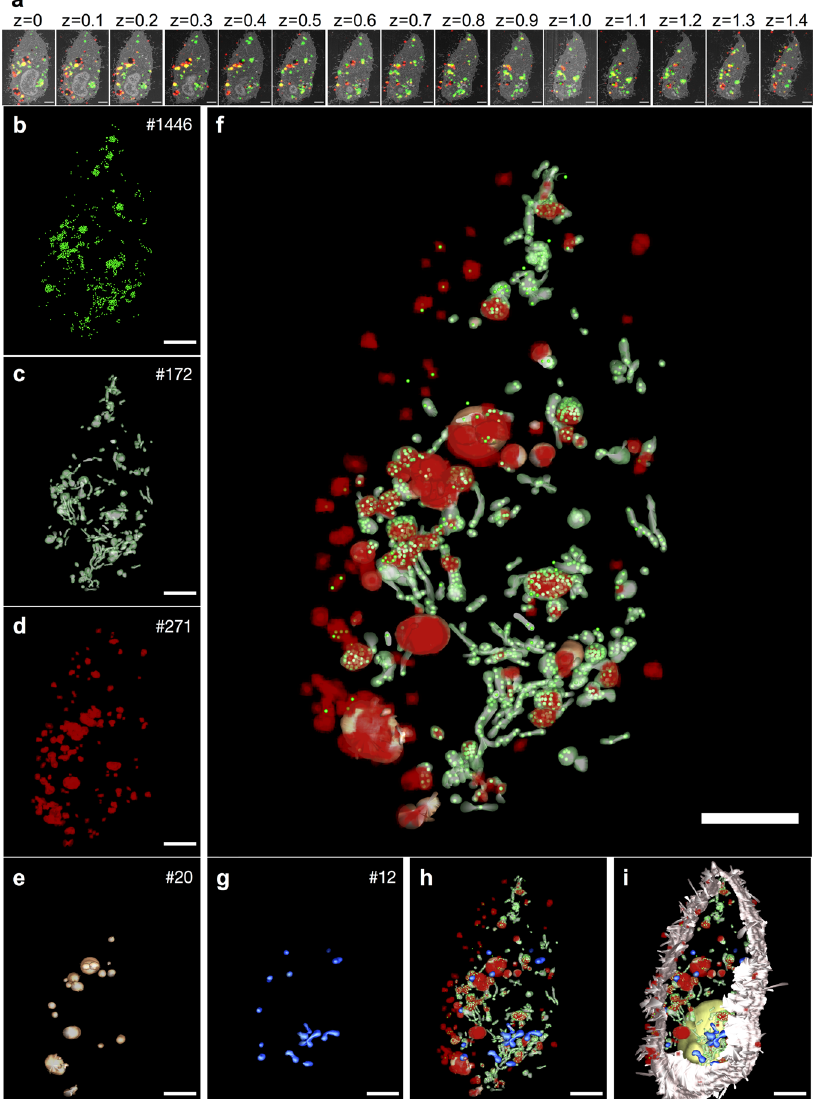
Fig. 3 | Volume CLEMofone celland segmentedmodel. PSNPswith Cy5-labeled protein corona were incubated with RAW264.7 cells and imaged in CLEM after 2h+24h. a CLEM micrographs of 15 physical EPON sections (100nm each). z representstherelativedepthofeachsectionin µ m.RedrepresentstheCy5-labeled protein corona, green represents BODIPY-labeled PS NPs, yellow represents the overlay of the protein corona and PS NPs. The enlarged images are provided in